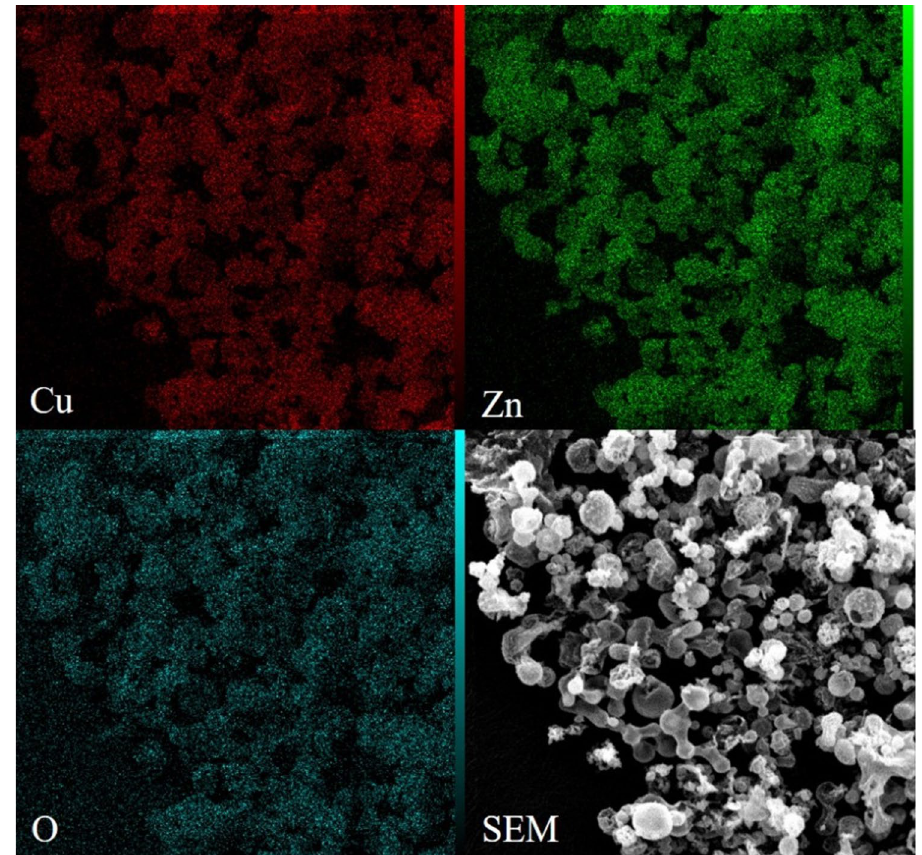
Figure 4. The elemental mapping technique of